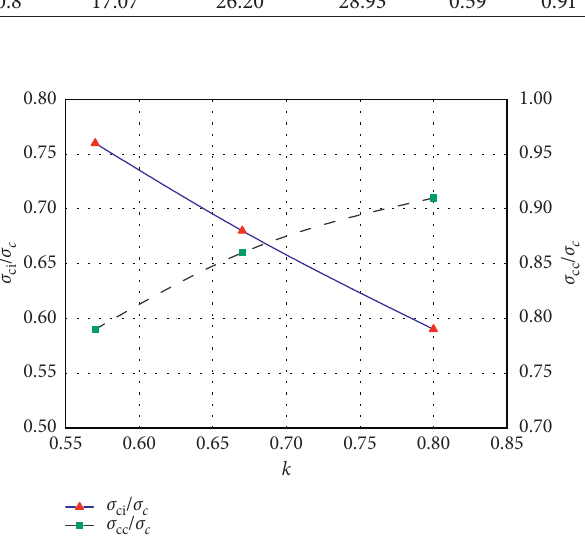
Figure 11: The angle between the main flaw and axial load α versus crack initiation and coalescence forces σ